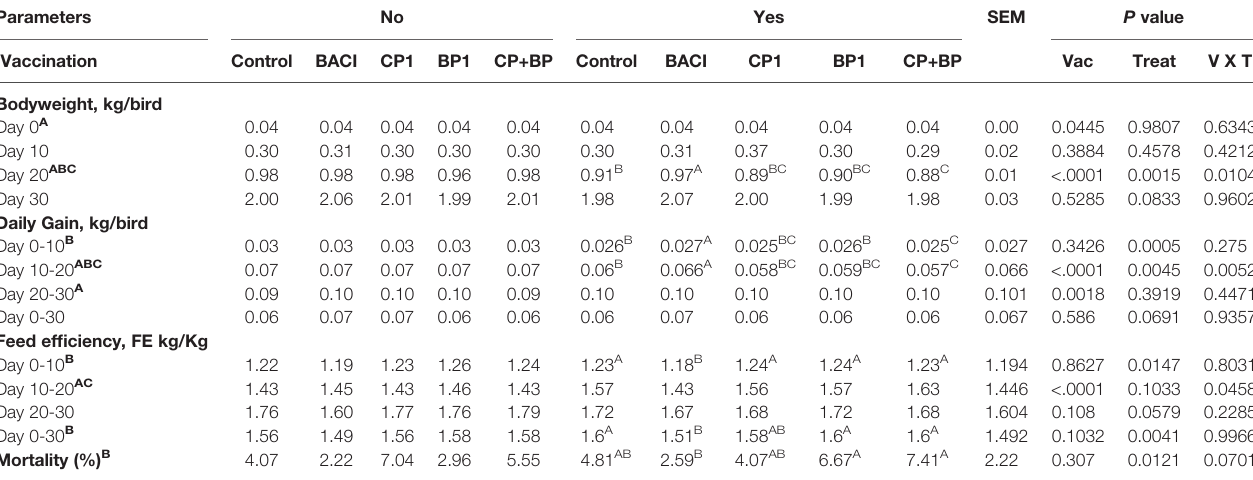
TABLE 2 | Effects of berry products and bacitracin on coccidiosis vaccinated or non-vaccinated broiler growth performances 1 . Parameters No Yes SEM P value Vaccination Bodyweight, kg/bird Day 0